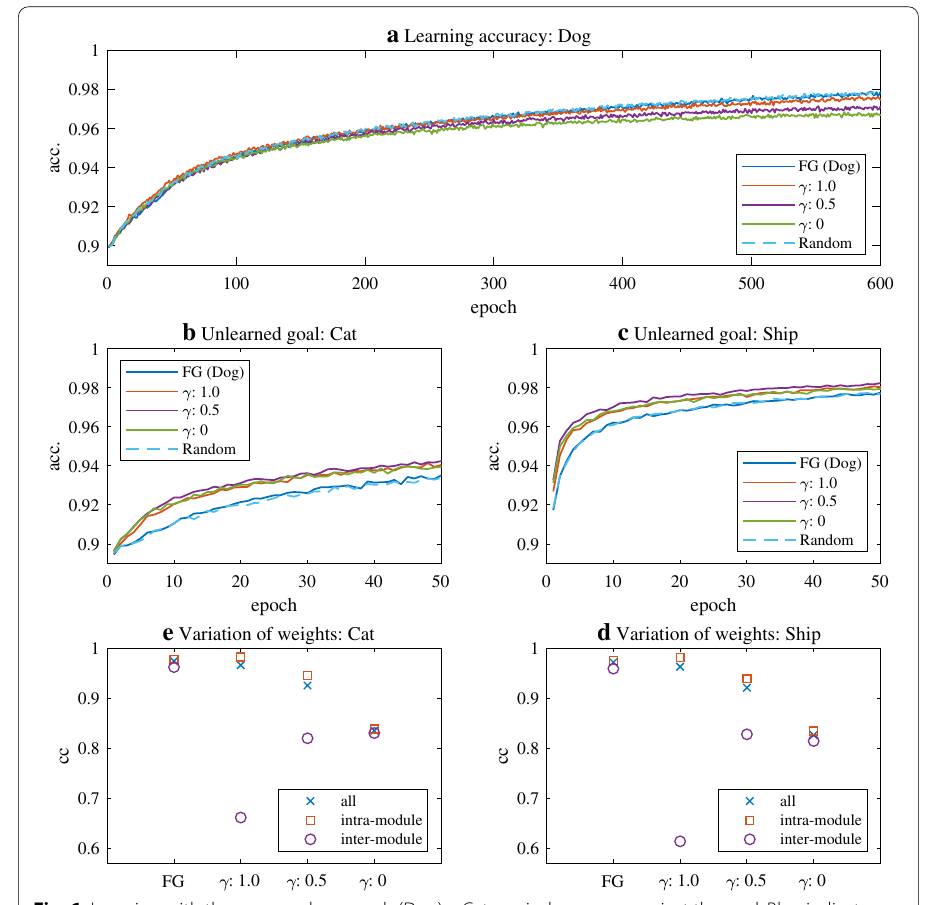
Fig. 6 Learning with the proposed approach (Dog) a Categorical accuracy against the goal. Blue indicates the FG of Dog. The orange line indicates interMOD 1.0 . The purple line indicates interMOD 0.5 . The green line indicates interMOD 0 . b , c Categorical accuracy against the unlearned goals Cat and Ship. The weights of the initial neural network are from the last epoch of ( a ). e , d Pearson’s correlation coefficient (cc) against before and after learning the unlearned goals Cat and Ship. The cc values of the filter elements of the initial neural network and the last neural network in ( b , c ) are shown. Blue indicates the cc values of all the filter elements. Red indicates the cc values of elements in the filter corresponding to intra-module links. Purple indicates the cc values of elements in the filter corresponding to inter-module